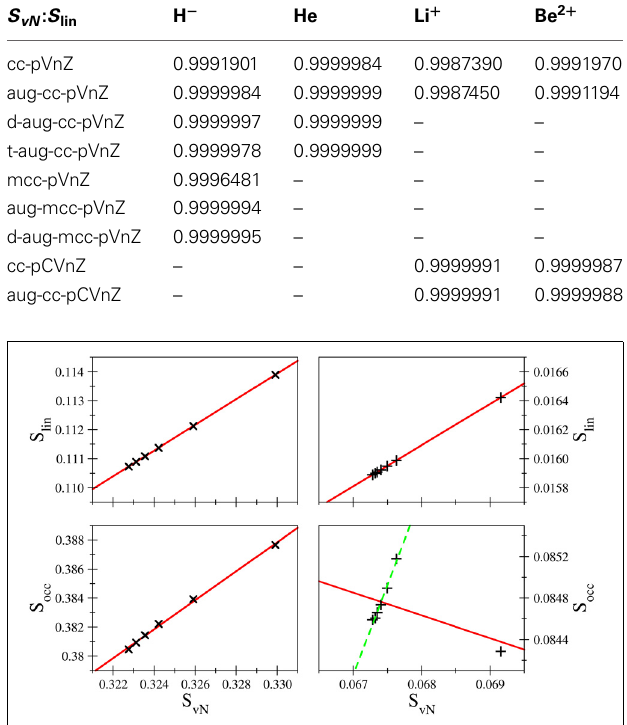
FIGURE 6 | Comparison of S lin and S occ as a function of S vN in case of H − (left) and helium (right) treated with d-aug-cc-pVnZ and t-aug-cc-pVnZ bases, respectively. While the linear entropy correlates very well with the von Neumann entropy in all cases, the occupation number entropy does not show a linear correlation in all